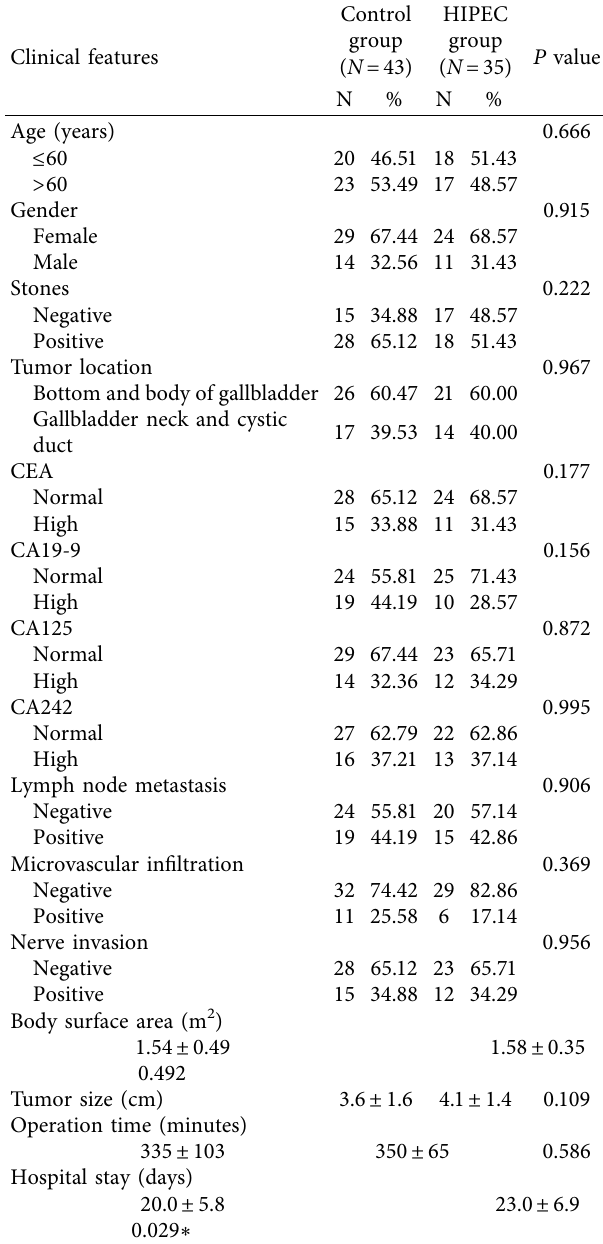
Note: χ 2 test was used to compare the distribution of clinical features between control group patients and HIPEC group patients. CA19-9